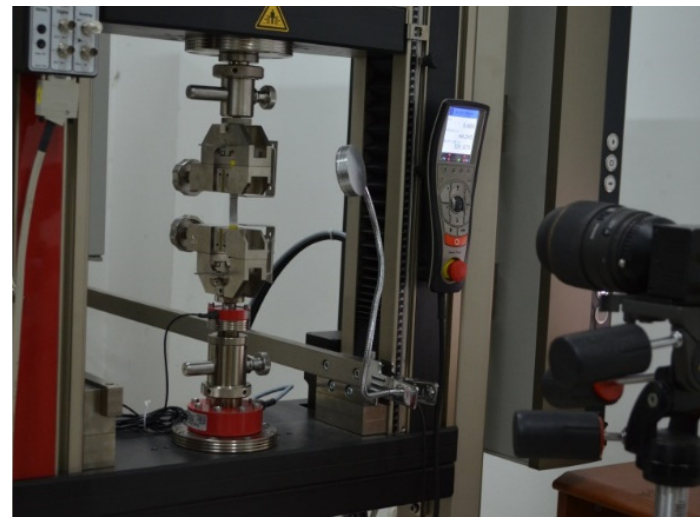
Figure 2. Experimental methodology. Zwick Z020 universal test machine and DIC system.